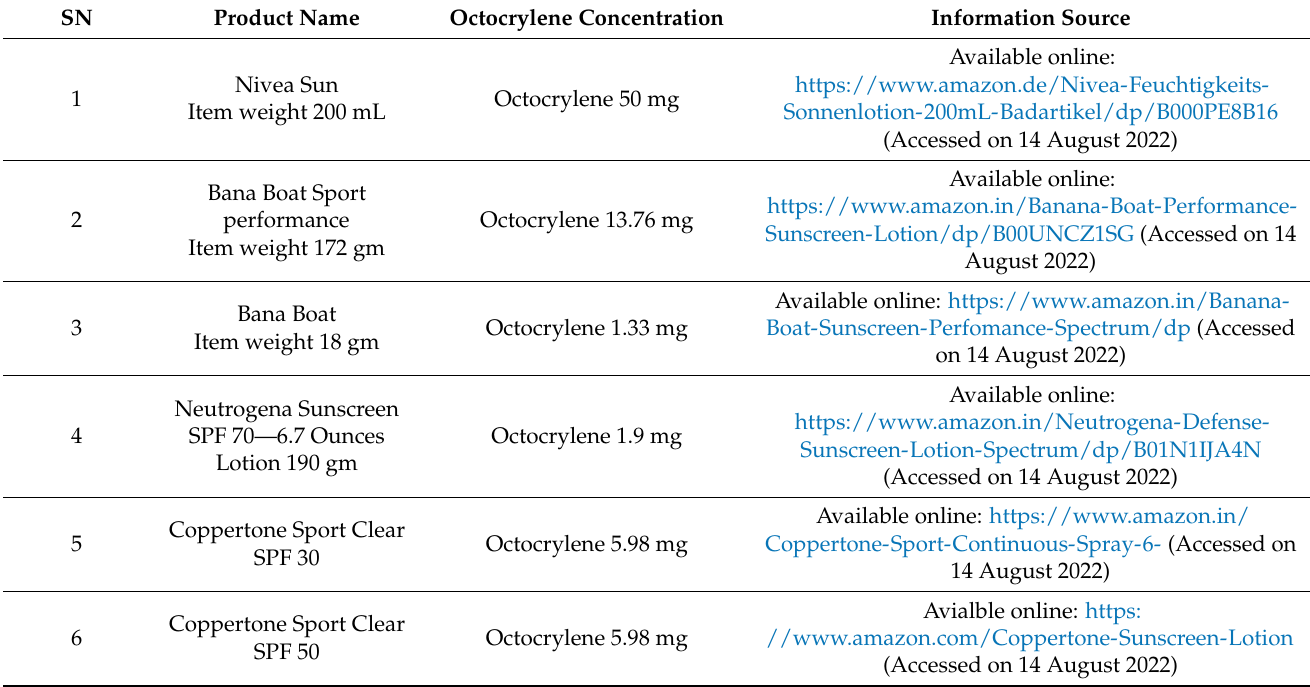
Figure 1. Chemical structure of octocrylene. Table 1. Example of brand and concentration of octocrylene.